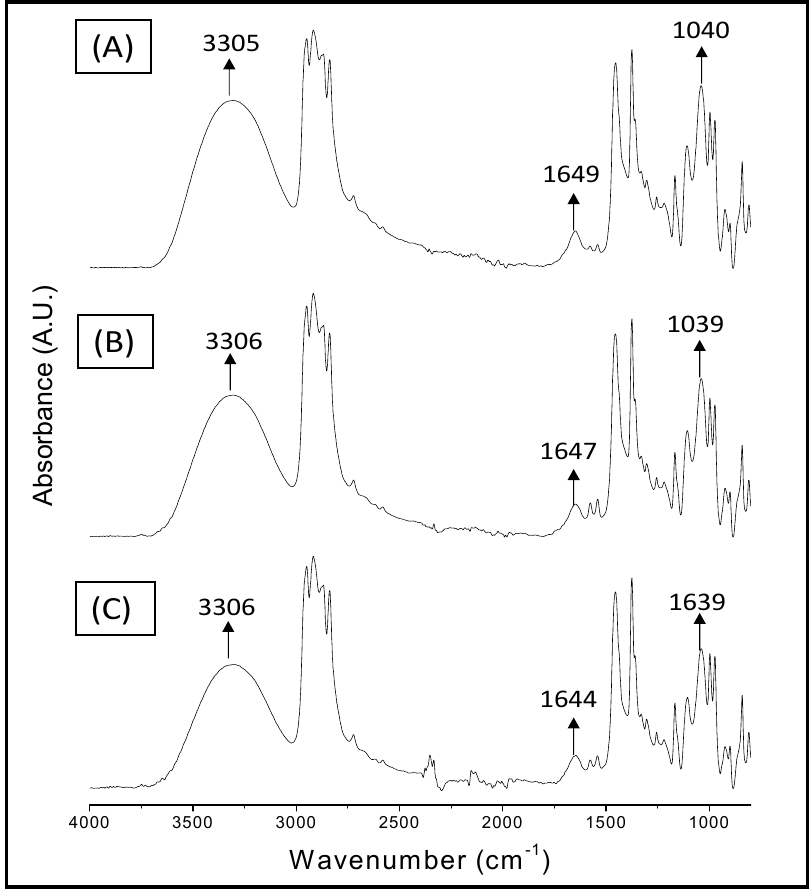
Figure 2. Infrared spectroscopy of ( A ) C5; ( B ) C7; ( C ) C9.